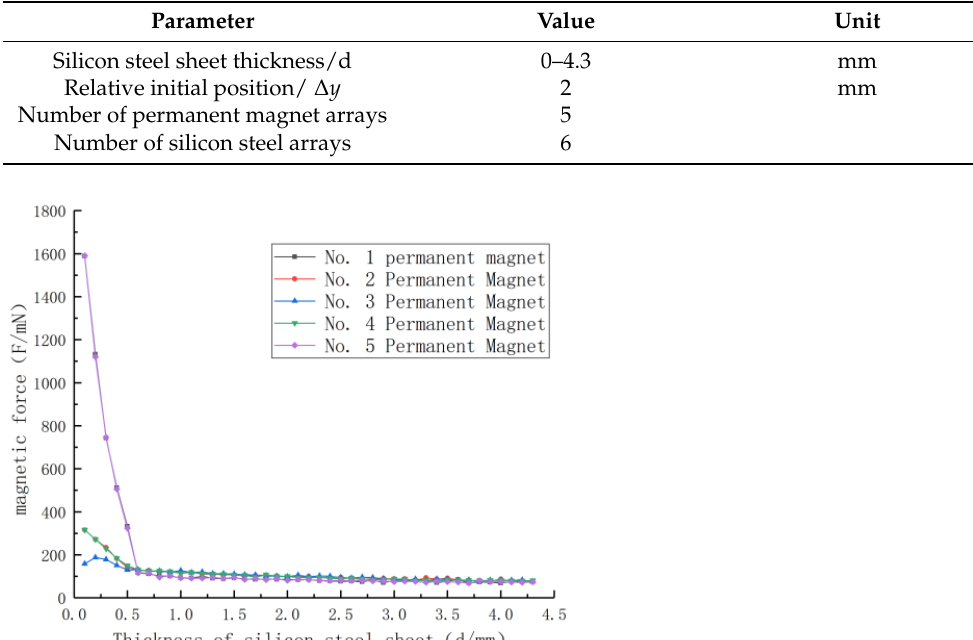
Figure 8. Variation curve of permanent magnet stress with silicon steel thickness.